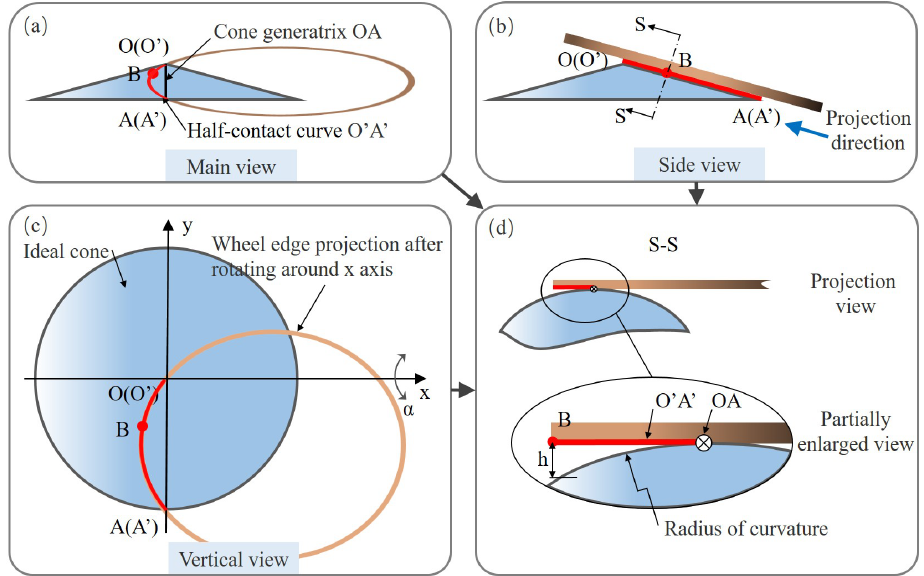
Figure 4. Geometrical schematic to analyze the envelope profile of wheel grinding edge after tilting around x -axis. ( a ) Main view. ( b ) Side view. ( c ) Vertical view. ( d ) Projection